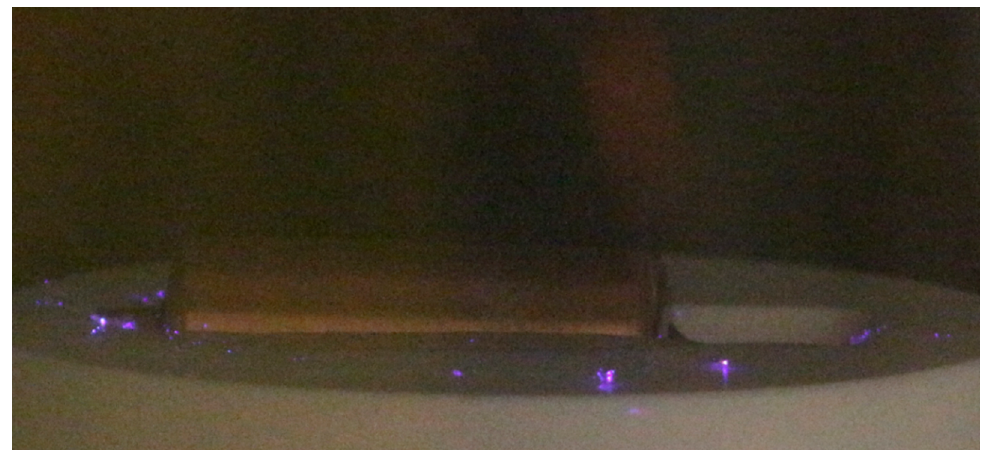
Figure A9. A 5-s exposure photograph of corona discharge on the solution bath near the rotating electrode. The discharge is occurring at the tips of electrospun fibers and fragments which have fallen onto the solution bath.